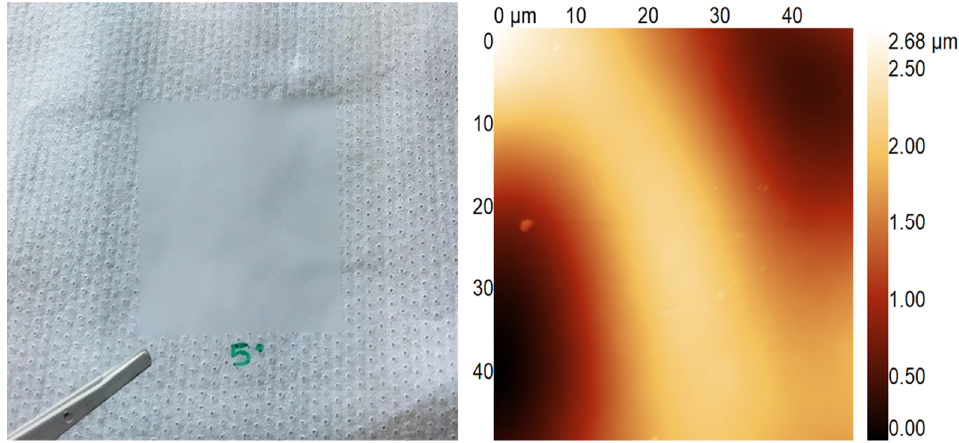
Figure 1. Left: photograph of the diffusor foil master. Right: AFM image of this master. The scan area is 50 × 50 µm².